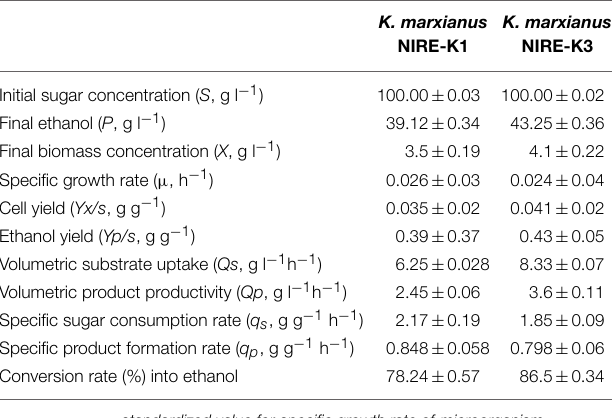
TABLE 6 | Growth and fermentation kinetics of K. marxianus NIRE-K1 and NIRE-K3 at optimized conditions.